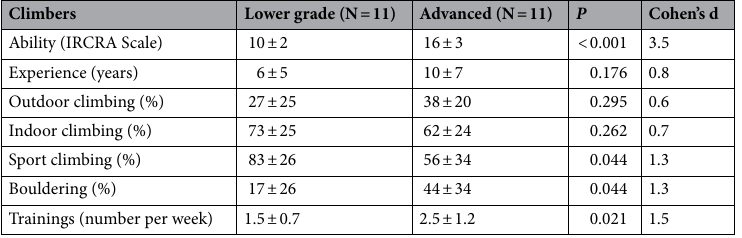
Table 1. Climbing ability and training characteristics (mean ± s ) in lower grade and advanced climbers. IRCRA international rock climbing research